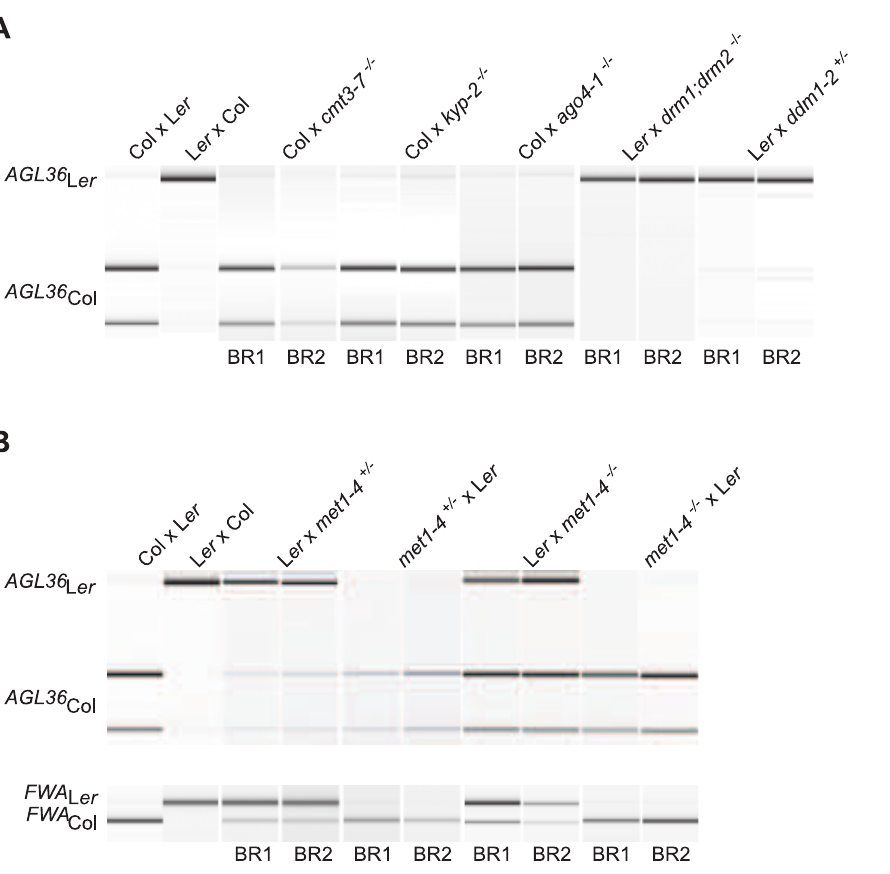
Figure 5. The effect of DNA methylation on parental AGL36 expression. (A,B) SNP analyses of 3 DAP seeds from crosses with DNA methylation mutants. The amplified SNP containing regions of AGL36 and FWA cDNA were digested with Alw NI and Nhe I, respectively, and analyzed in a Bioanalyzer. (A) Homozygous cmt3-7 , kyp-2 , and ago4-1 mutants in the L er ecotype were used as pollen donors to pollinate Col plants, while homozygous drm1;drm2 and heterozygous ddm1-2 mutants in the Ws-2 and Col ecotype respectively, were used as male to fertilize L er ovules. No paternal AGL36 expression could be detected in these crosses. (B) Upper panel: Hemizygous met1-4 + / 2 in the Col ecotype reciprocally crossed with L er wild-type plants show that the paternal allele of AGL36 is expressed when met1-4 is crossed as male. No paternal bands are observed when met1-4 is used as the maternal cross partner. Using pollen from first generation met1-4 2 / 2 homozygous plants in a L er x met1-4 2 / 2 cross gives rise to prominent bands of the digested paternal Col expression product. In the reciprocal met1-4 2 / 2 x L er cross no paternal expression can be detected. Lower panel: FWA control using the same tissue as above showing imprinted expression of FWA in dependence of MET1. Paternal FWA expression was observed when plants hemizygous and homozygous for met1-4 were crossed as male to L er wild-type.